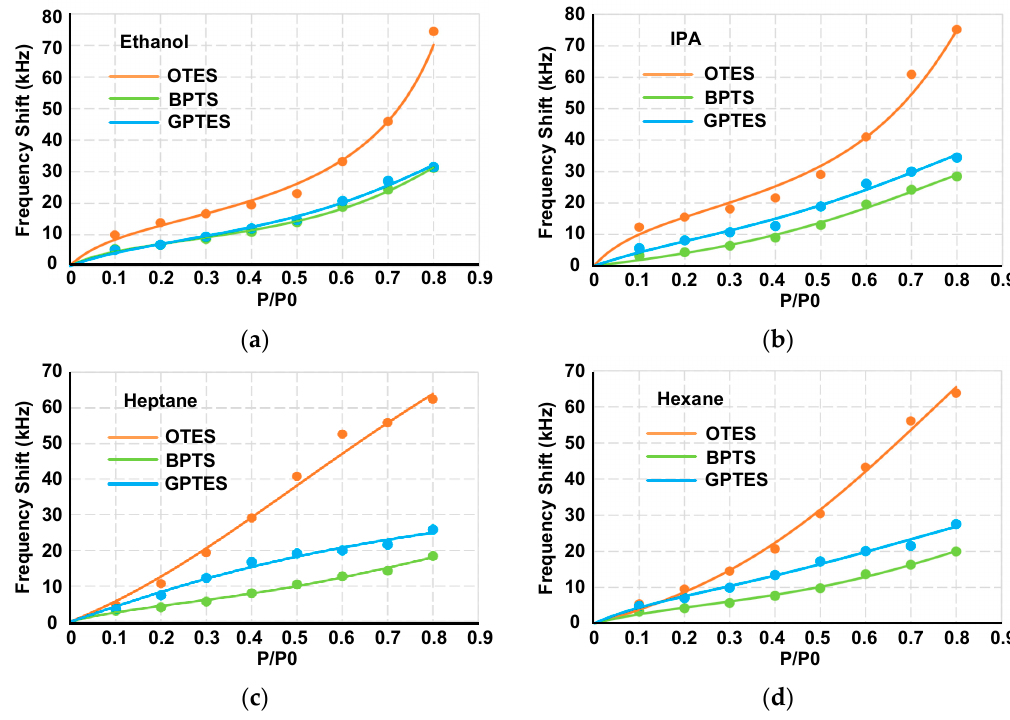
Figure 8. Adsorption isotherms of VOCs: ( a ) ethanol, ( b ) IPA, ( c ) heptane and ( d ) hexane.